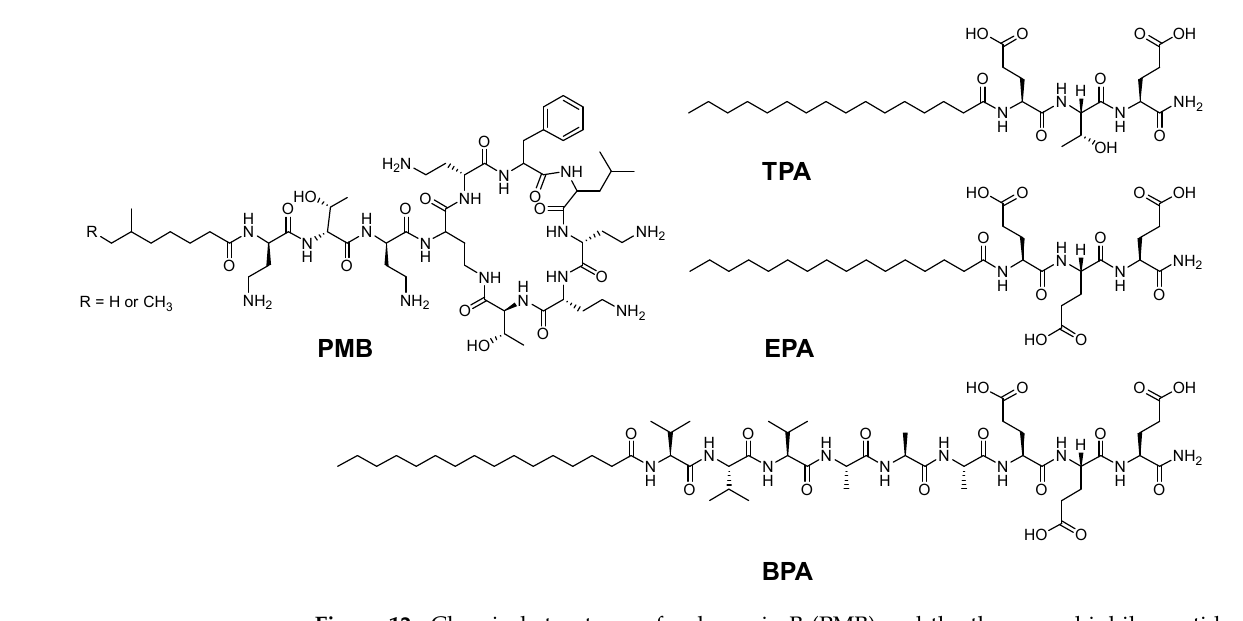
Figure 12. Chemical structures of polymyxin B (PMB) and the three amphiphile peptides (PA): thre- onine (T)-containing PA (TPA), glutamic acid (E)-containing PA (EPA), and beta-sheet-forming PA (BPA).